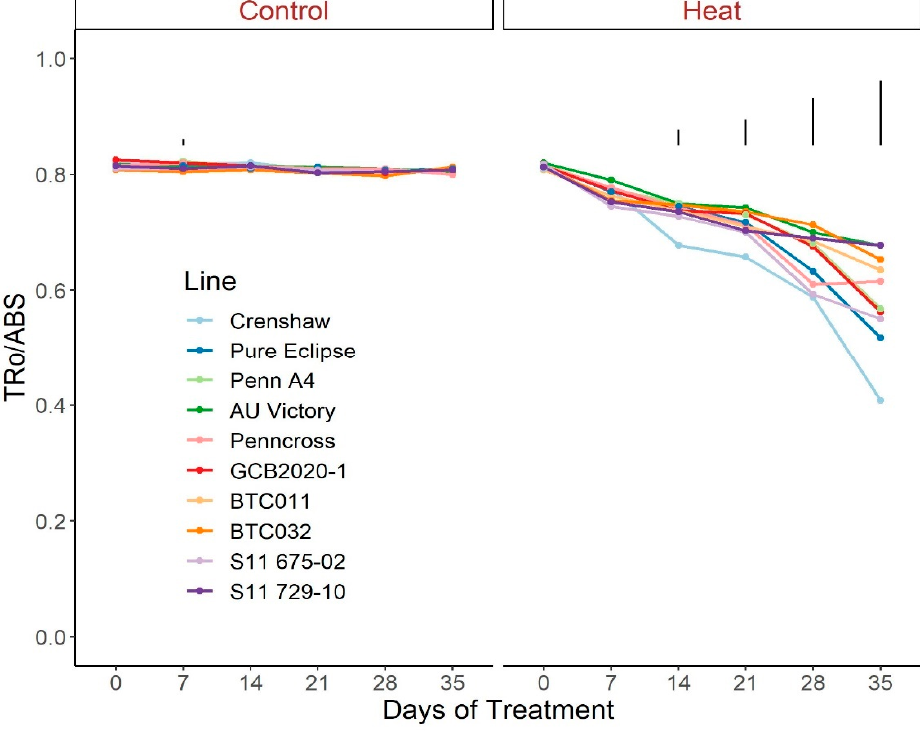
Figure 4. Change in Tro/ABS for creeping bentgrass lines over time under control (20/15 °C day/night) and heat stress (38/33 °C day/night) conditions. Bars represent LSD values at p = 0.05 on days when significant differences among lines were found.